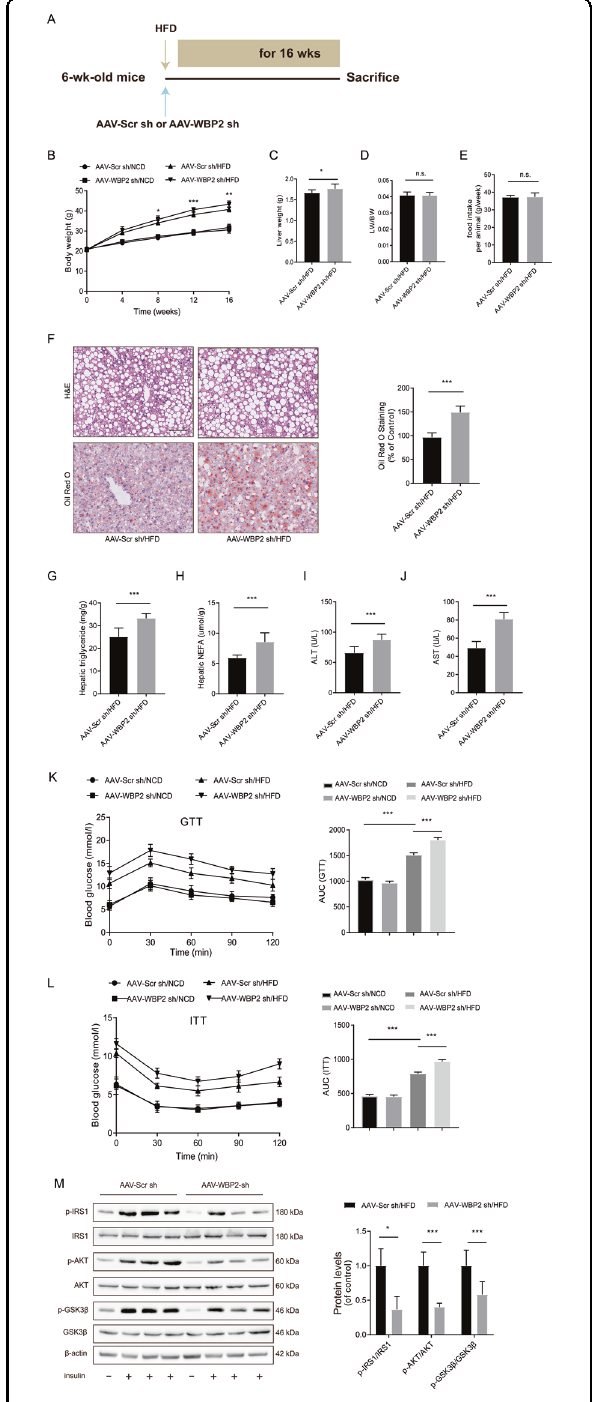
WT AMPK β 1 instead of the Ser108 mutant (Fig. 6C).